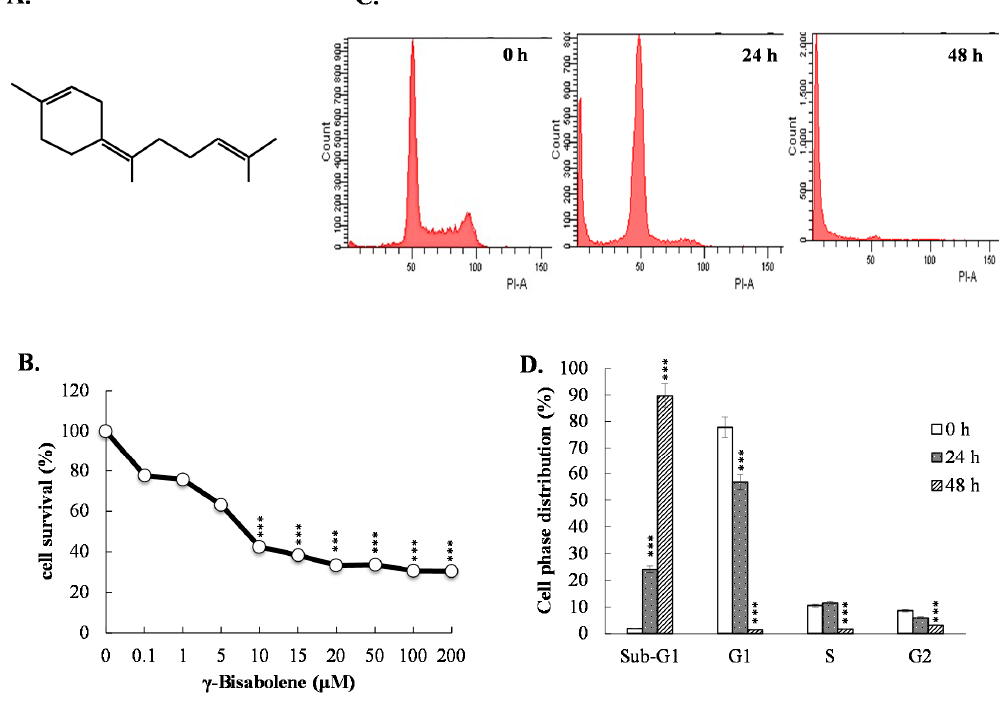
Figure 1. Survival rates and cell cycle analysis of human neuroblastom cells in response to γ -bisabolene.